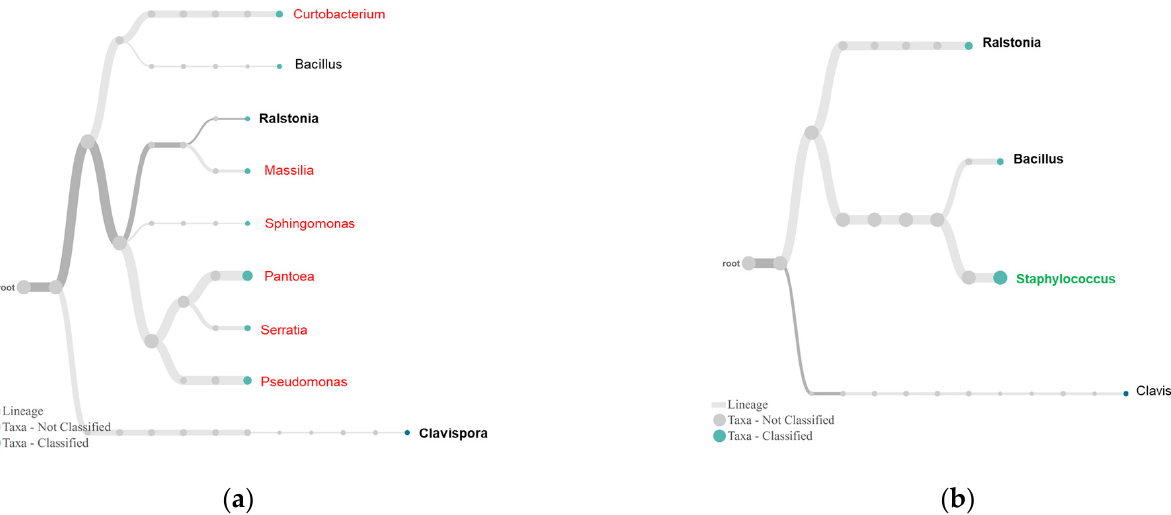
Figure 6. Endophytes in susceptible RfB ( a ) and tolerant VbM ( b ) plants. By default, the trees were constructed with WIMP presenting the top 30 taxa at abundance >1% and a taxonomic rank of genus. Taxonomic lineages in bold are predominant in the samples, and those in color are unique to the plant group.